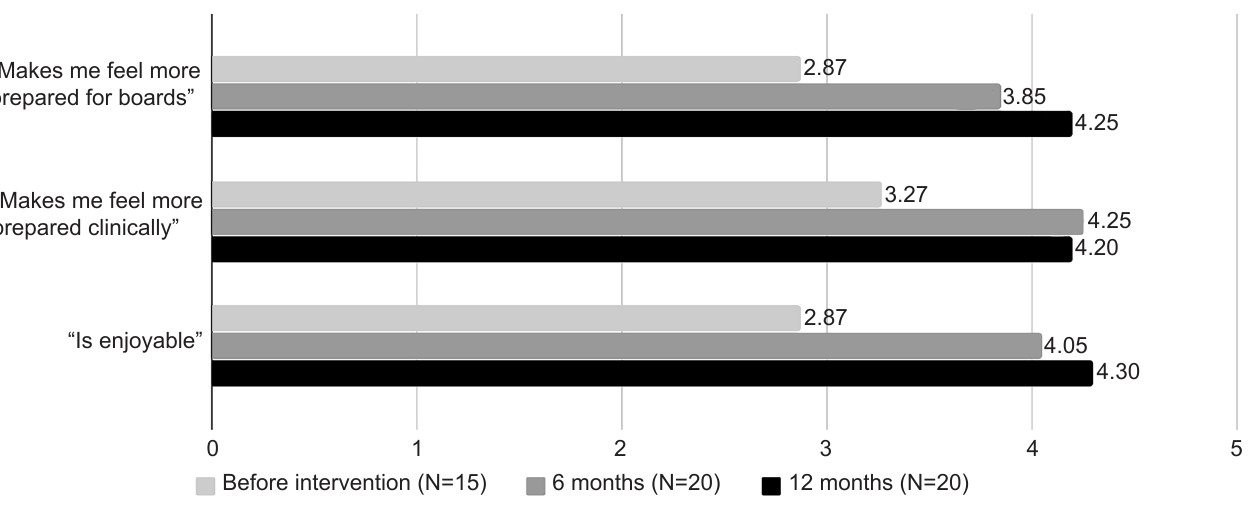
Figure. Resident response to intervention based on standardized Likert